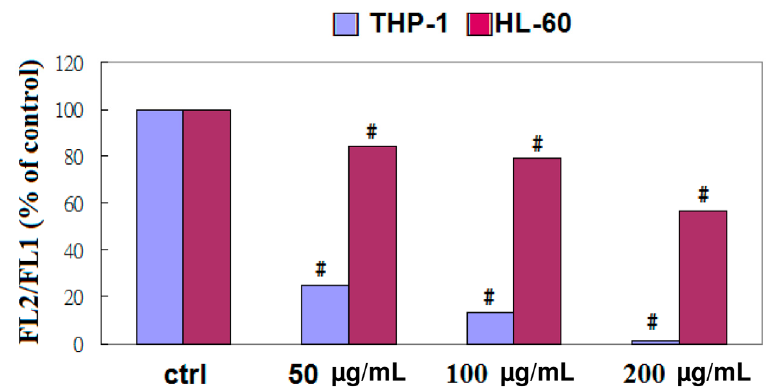
Figure 4. Mitochondrial membrane potential ( ΔΨ m) of THP-1 (blue) and HL-60 (red) cells was analyzed with cytofluorometry by double staining for JC-1 and PI after the cells were treated with 50 μ g/mL, 100 μ g/mL, or 200 μ g/mL EFW for 24 h. The control was untreated cells. All of the experiments were performed at least three times, and all the results were obtained from three independent experiments. The symbol # indicates a significant difference between the treatment and control groups with p <